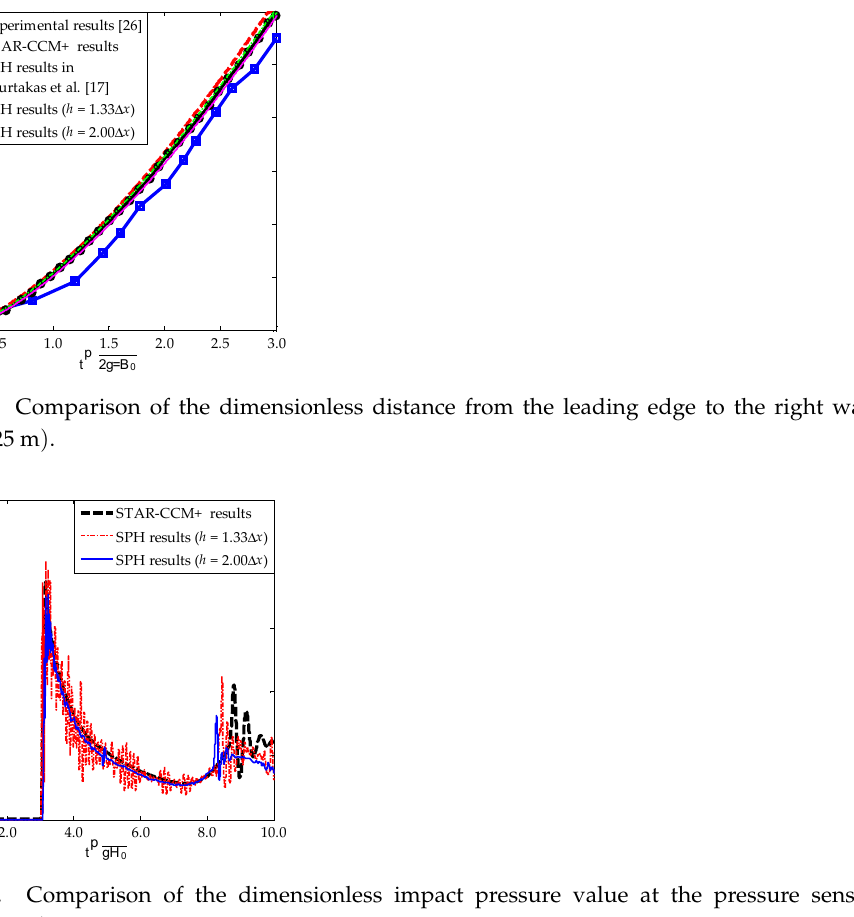
= g ( n π / B ) tanh ( n π ( d / B )) , and the first order natural frequency is frequency of ω 2 S 1 S 1 n ω 0 = 4.76 . As in the SPH simulations in Chen et al. [3], the SPH simulation parameters of the fluid particles are ρ = 1000 kg/m 3 and c s = 20 m/s. The artificial viscosity is α = 0.02. The particle spacing is set to ∆ x = 0.01 m, resulting in approximately 2970 fluid particles. The time step is 0.00005 s. The no-slip boundary condition is imposed on the fluid particles near the